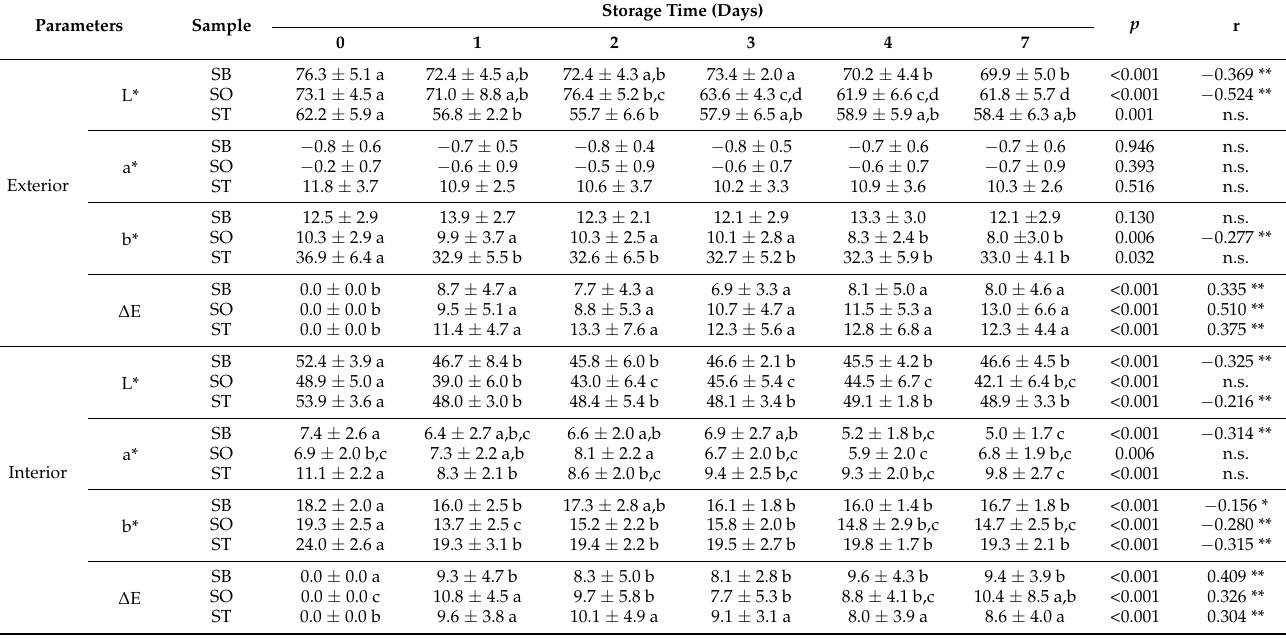
Table 3. Instrumental colour of sardines during storage at 4 ◦ C (mean ± standard